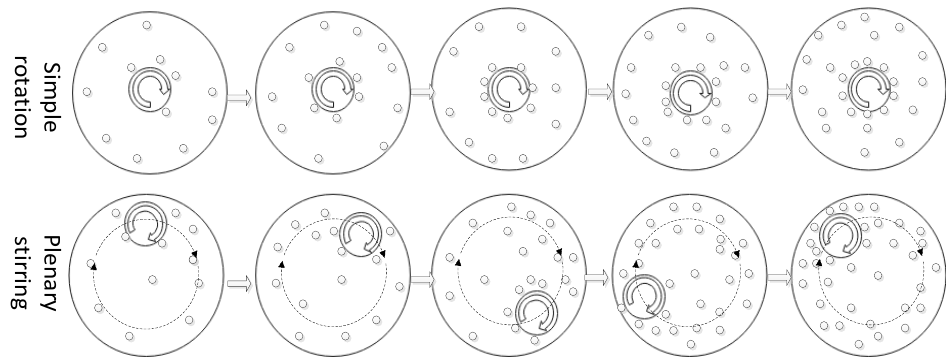
Figure 10. Diagram of crystal dissociation of different stirring process.